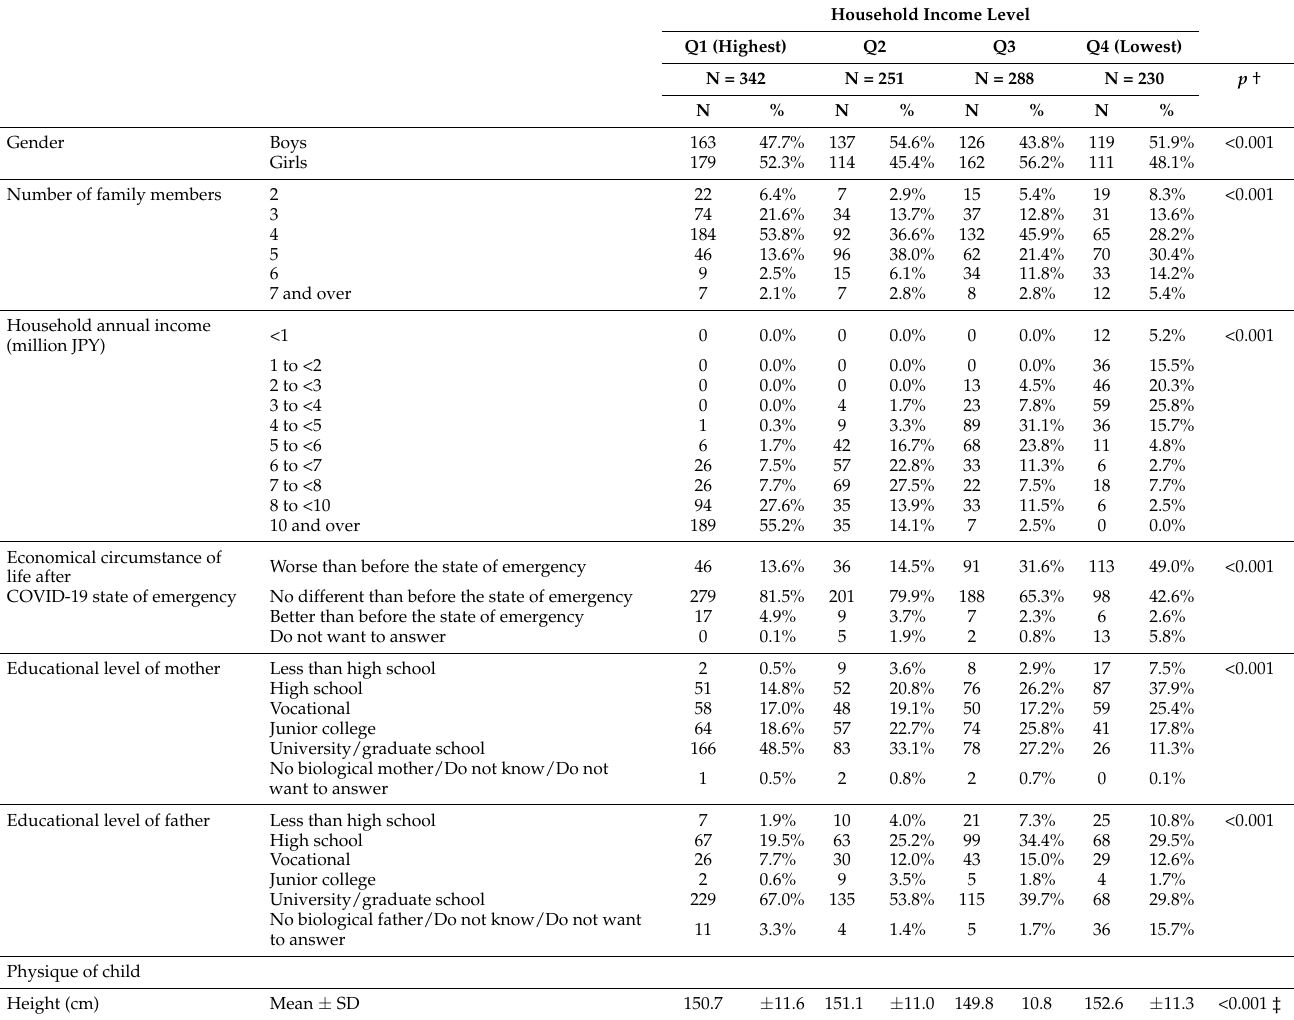
Table 2. Characteristics of participants according to household income level: 10–14-year-old schoolchildren in